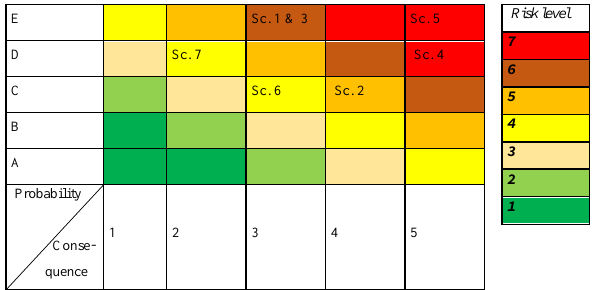
Table 10. Results from the semi-quantitative